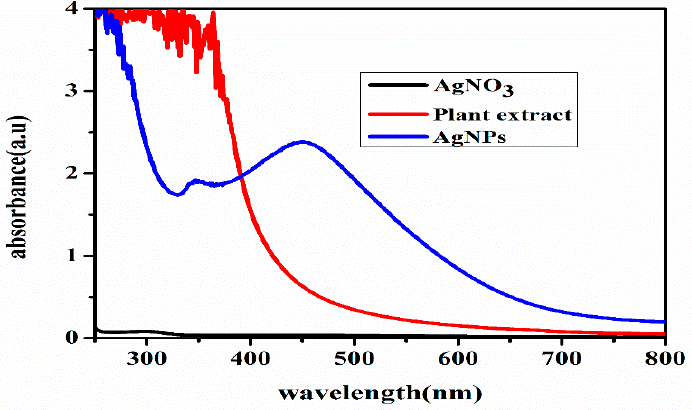
Figure 2. UV. Visible spectroscopy of AgNPs.